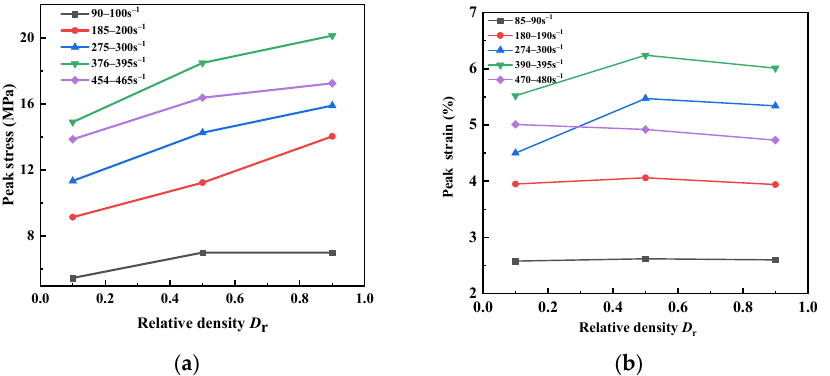
( a ) ( b ) Figure 18. Peak stress and peak strain with relative density for sand specimens at different strain rates. ( a ) Peak stress; ( b ) Peak strain.